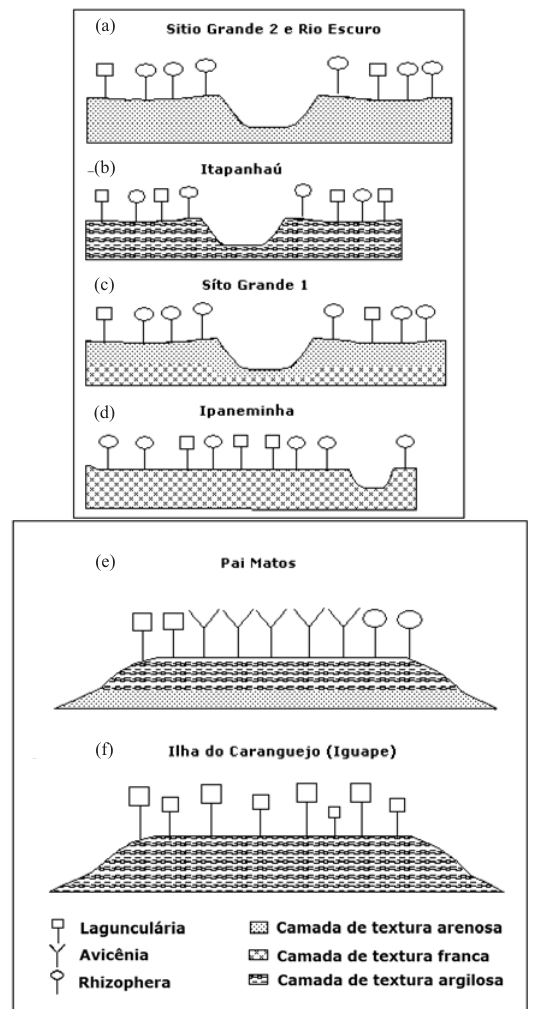
Figura 4. Modelos dos manguezais localizados às margens de rios. (a) substrato arenoso ao longo do perfil; (b) substrato argiloso ao longo do perfil; (c) substrato arenoso na superfície e textura franca na base; (d) tipo bacia, com substrato de textura franca ao longo do perfil – modelos dos manguezais do tipo ilha; (e) substrato argiloso sobre uma camada arenosa; (f) substrato de textura argilosa ao longo do